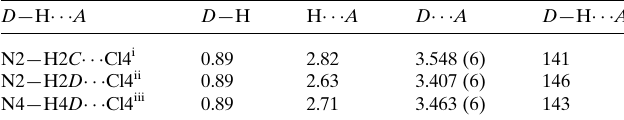
Table 1 Hydrogen-bond geometry (A˚ , (cid:4) ).